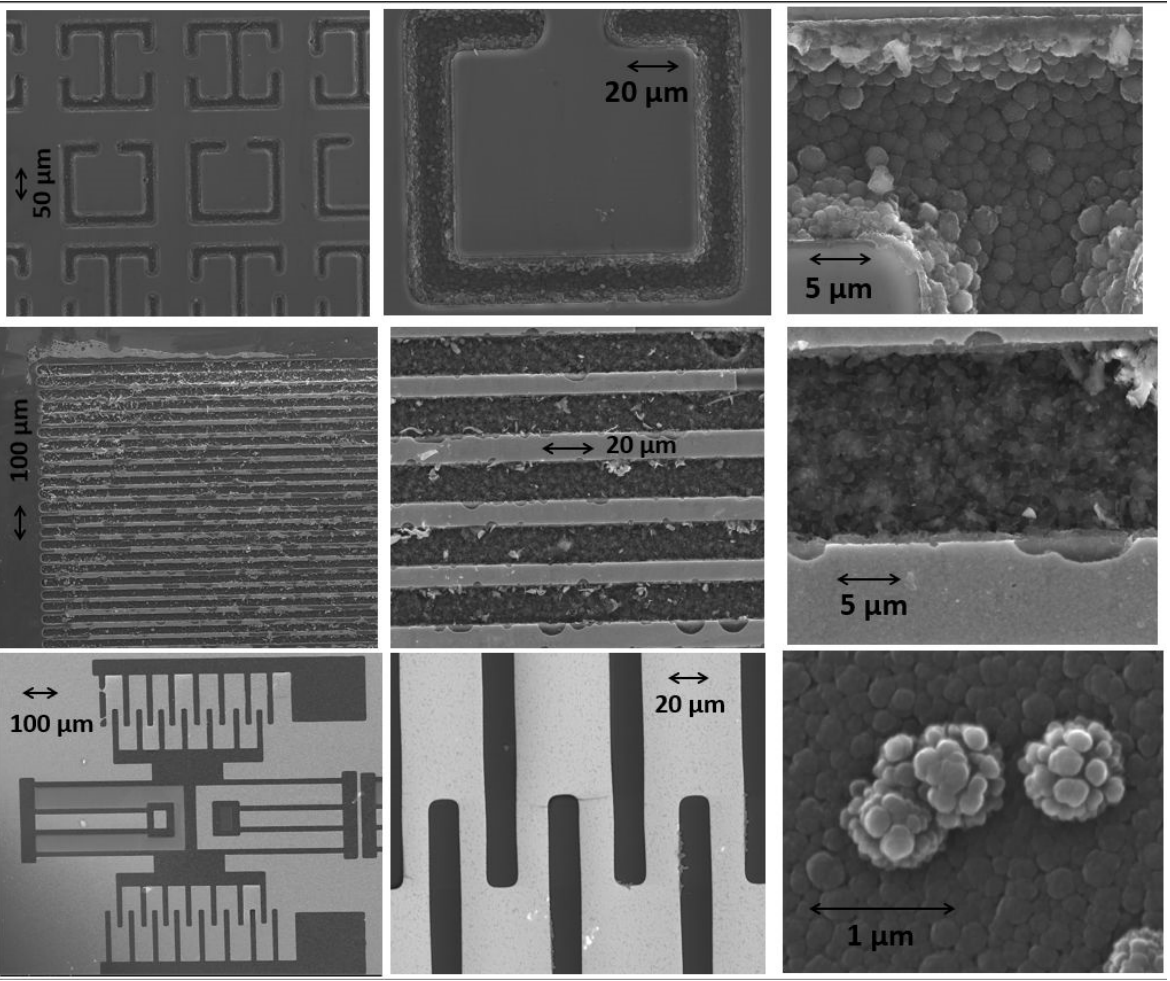
Figure 4. SEM images of B-C microstructures grown on silicon substrates. The shapes in the top row are inspired by radio frequency (RF) ring resonator structures. The middle row shows a densely packed grid of B-C microstructures with a gap of 10 microns between the lines. The bottom row shows B-C microstructures in the geometry of a MEMS resonator.